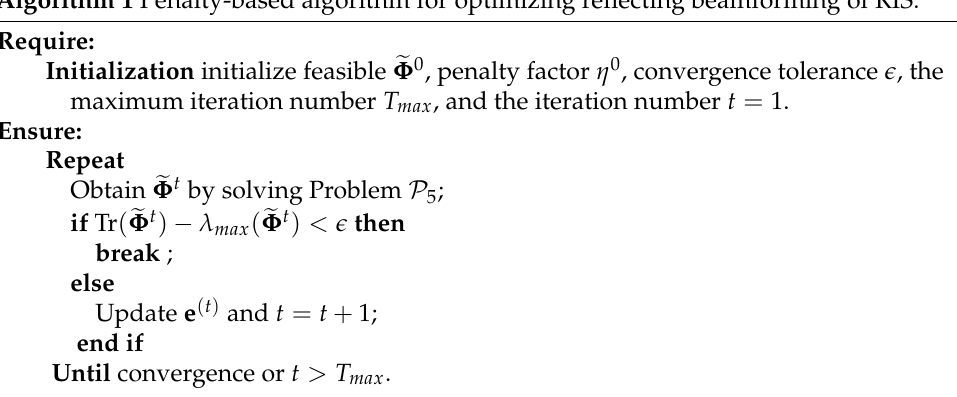
Algorithm 1 Penalty-based algorithm for optimizing reflecting beamforming of RIS.